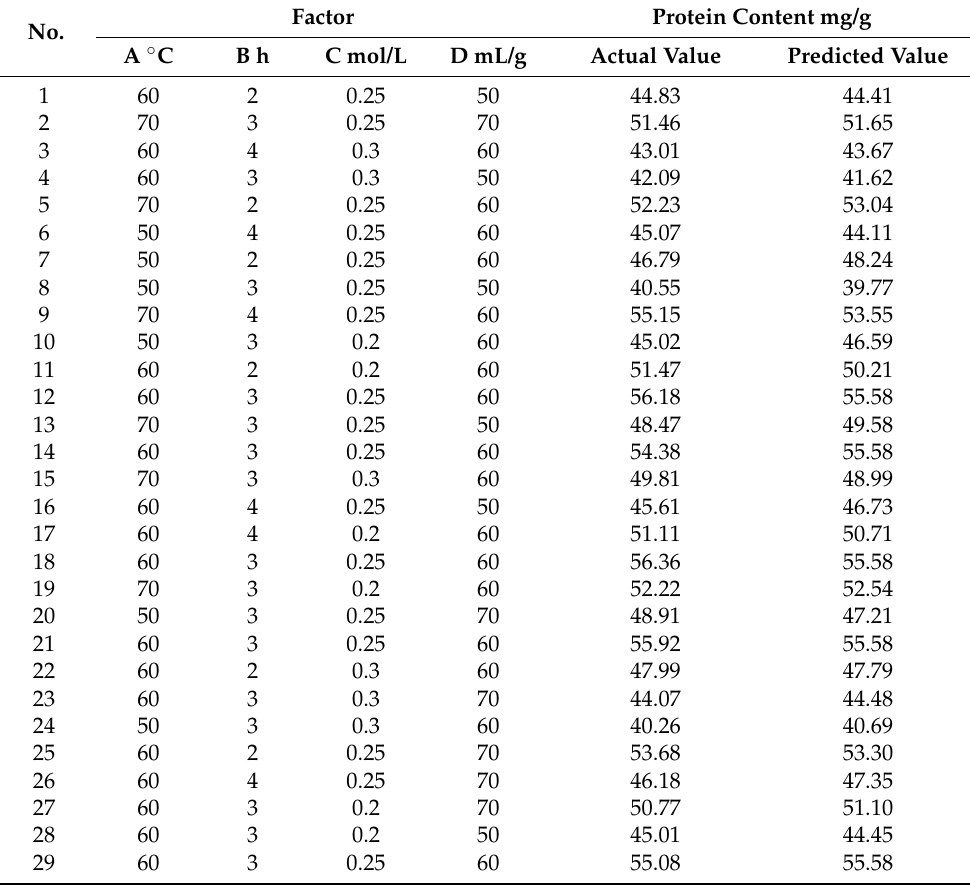
Table 1. Design scheme and result of response surface